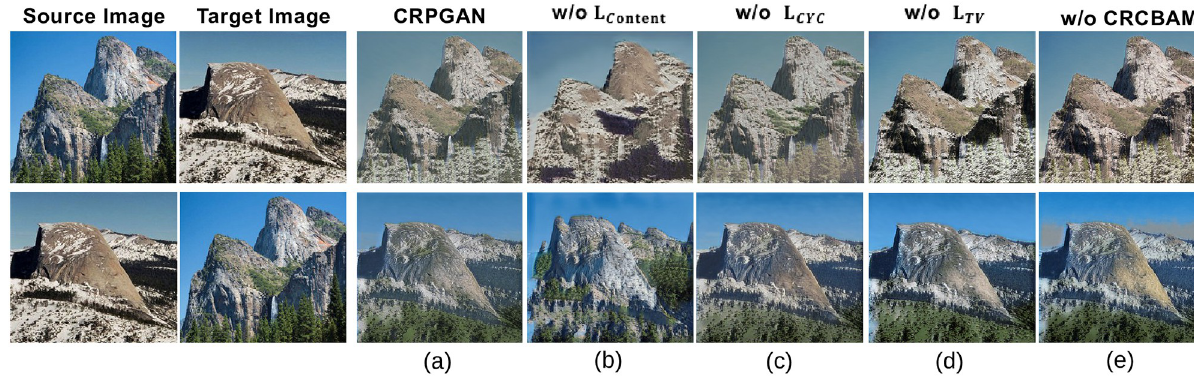
Fig 12. Visual results of ablation study.